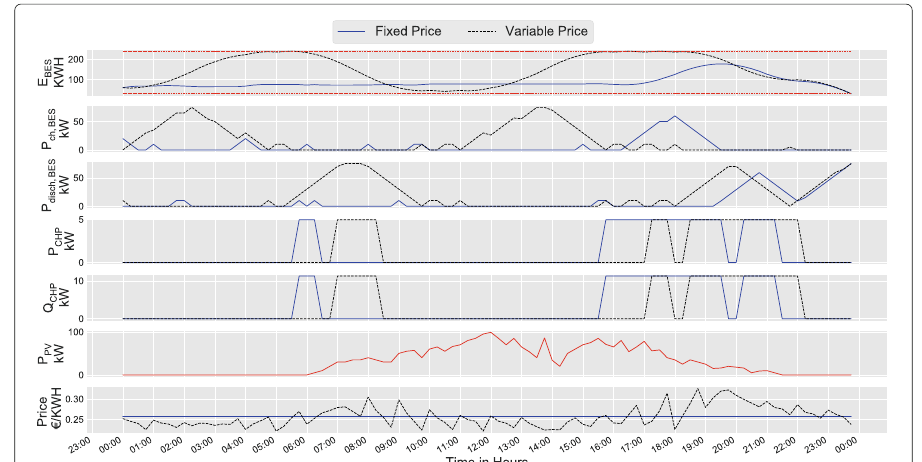
Fig. 9 Energy content, charging and discharging profiles for BES and CHP inputs